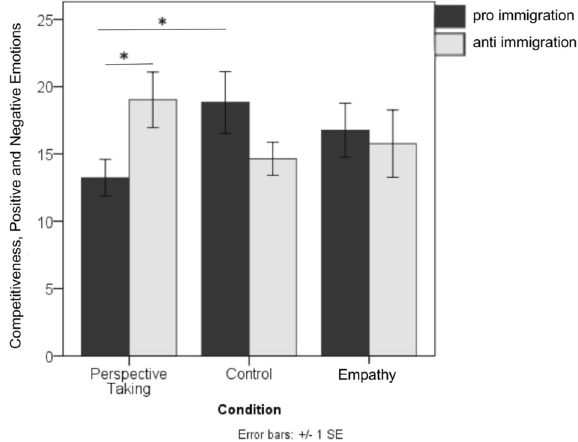
Fig. 2 Pro-immigration participants in the perspective-taking group had lower scores of competitiveness and emotions than did pro-immigration participants in the control group or anti-immigration participants in the perspective-taking group. The graph depicts mean scores of the composite score Competitiveness and Positive and Negative Emotions for the conditions perspective taking, control, and empathy. Error bars depict ± 1 standard error. * p <